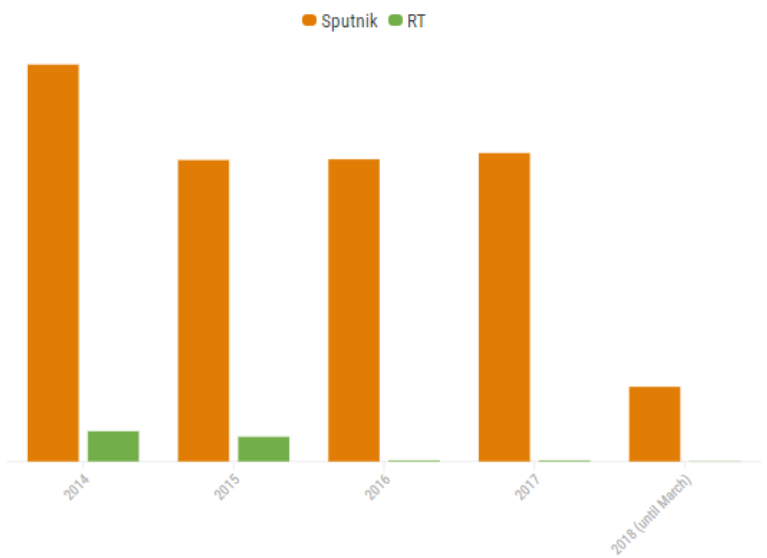
Figure 1: Number of Publications Registered by Year and by Media (Source: Authors‟ depiction based on the registry of publications on the websites of both